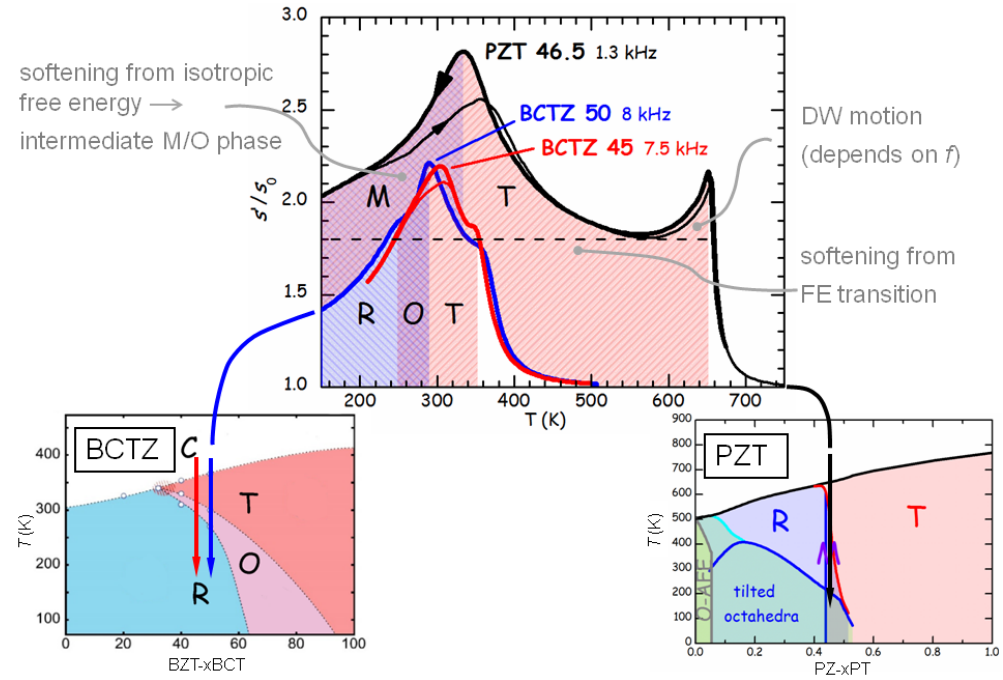
Figure 20. Comparison between the elastic compliances of BCTZ and PZT and paths followed in the respective phase